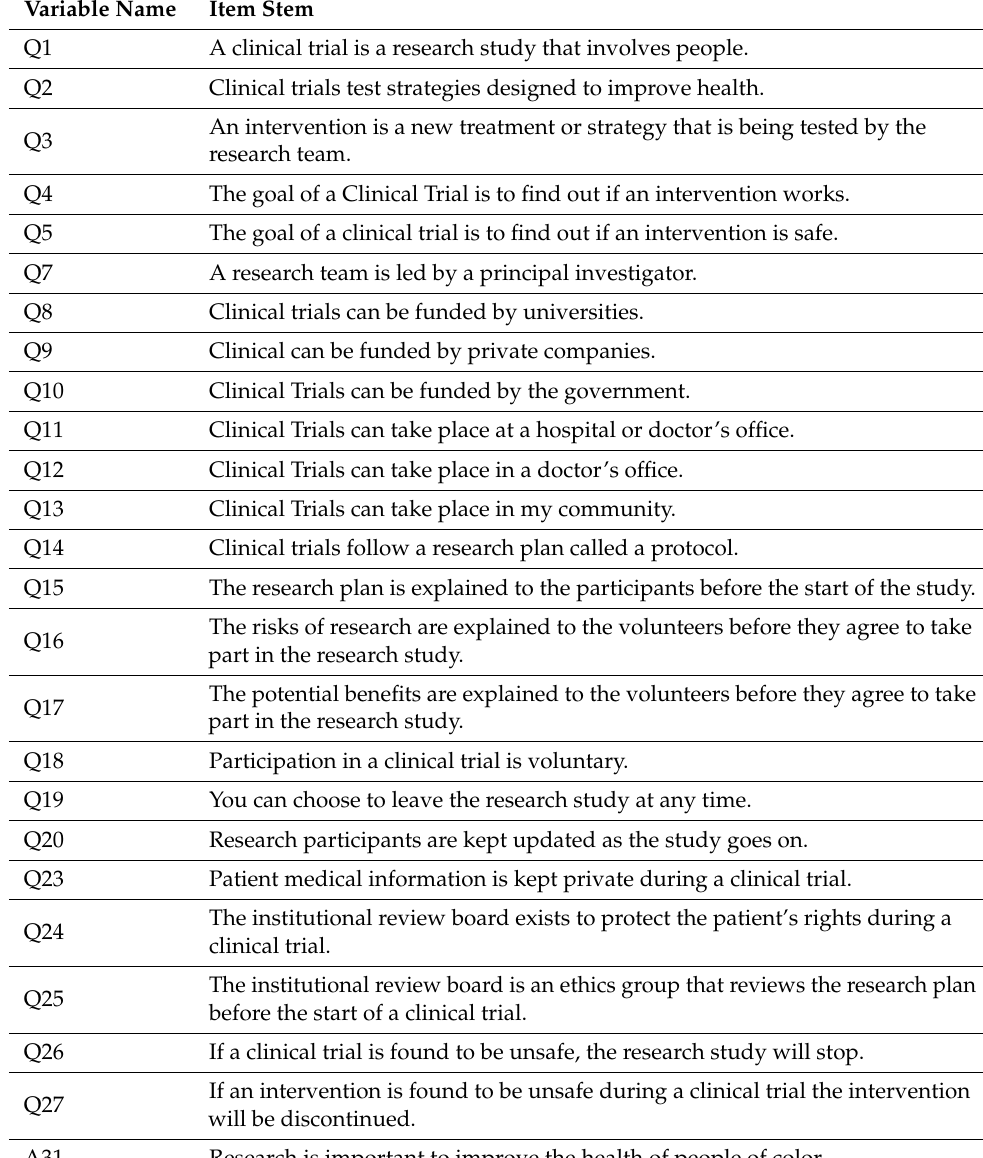
Table 1. Final survey items included in the Clinical Trial Health Knowledge and Beliefs Scale